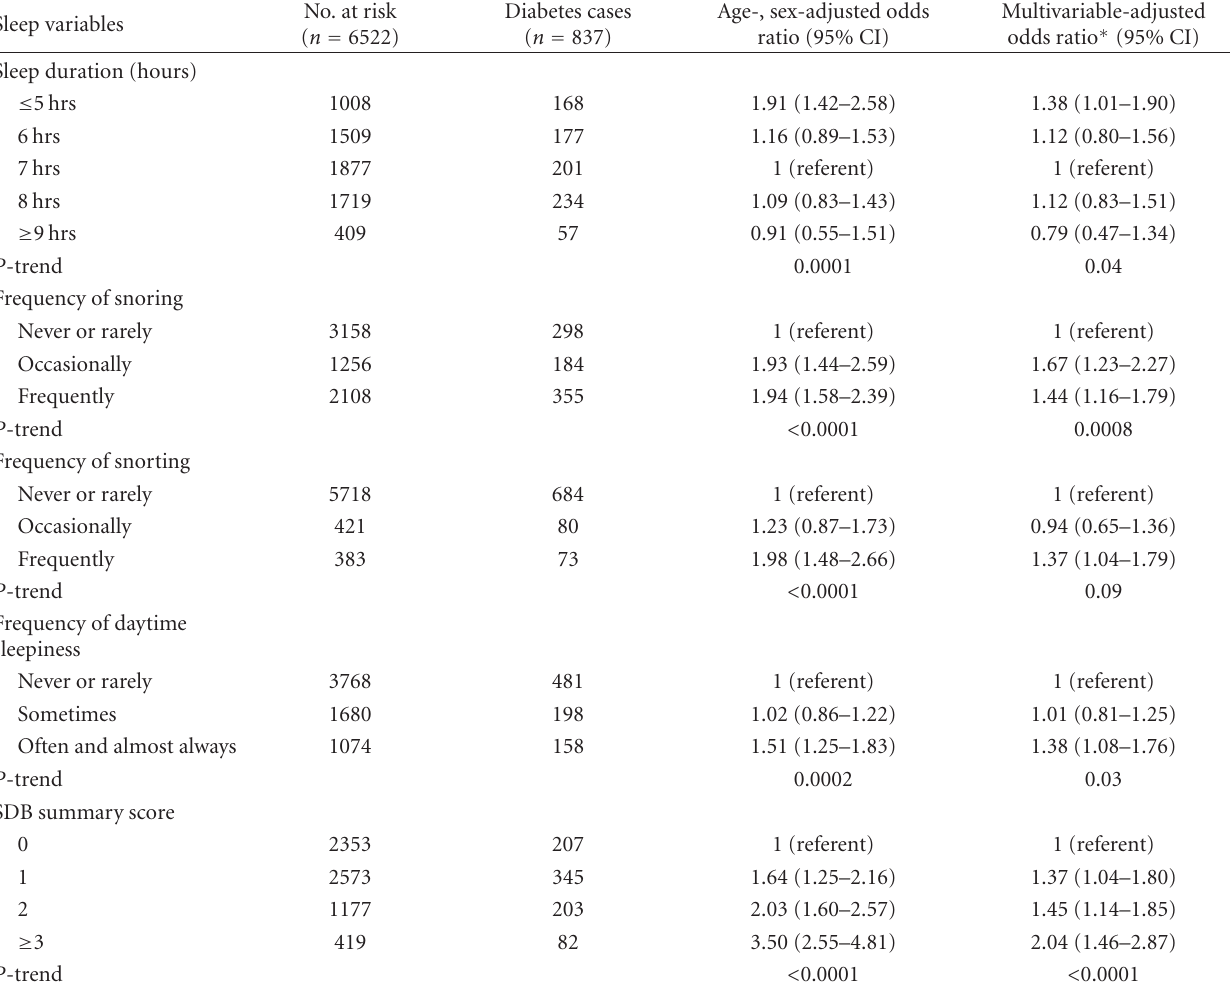
Table 2: Association between sleep variables and diabetes